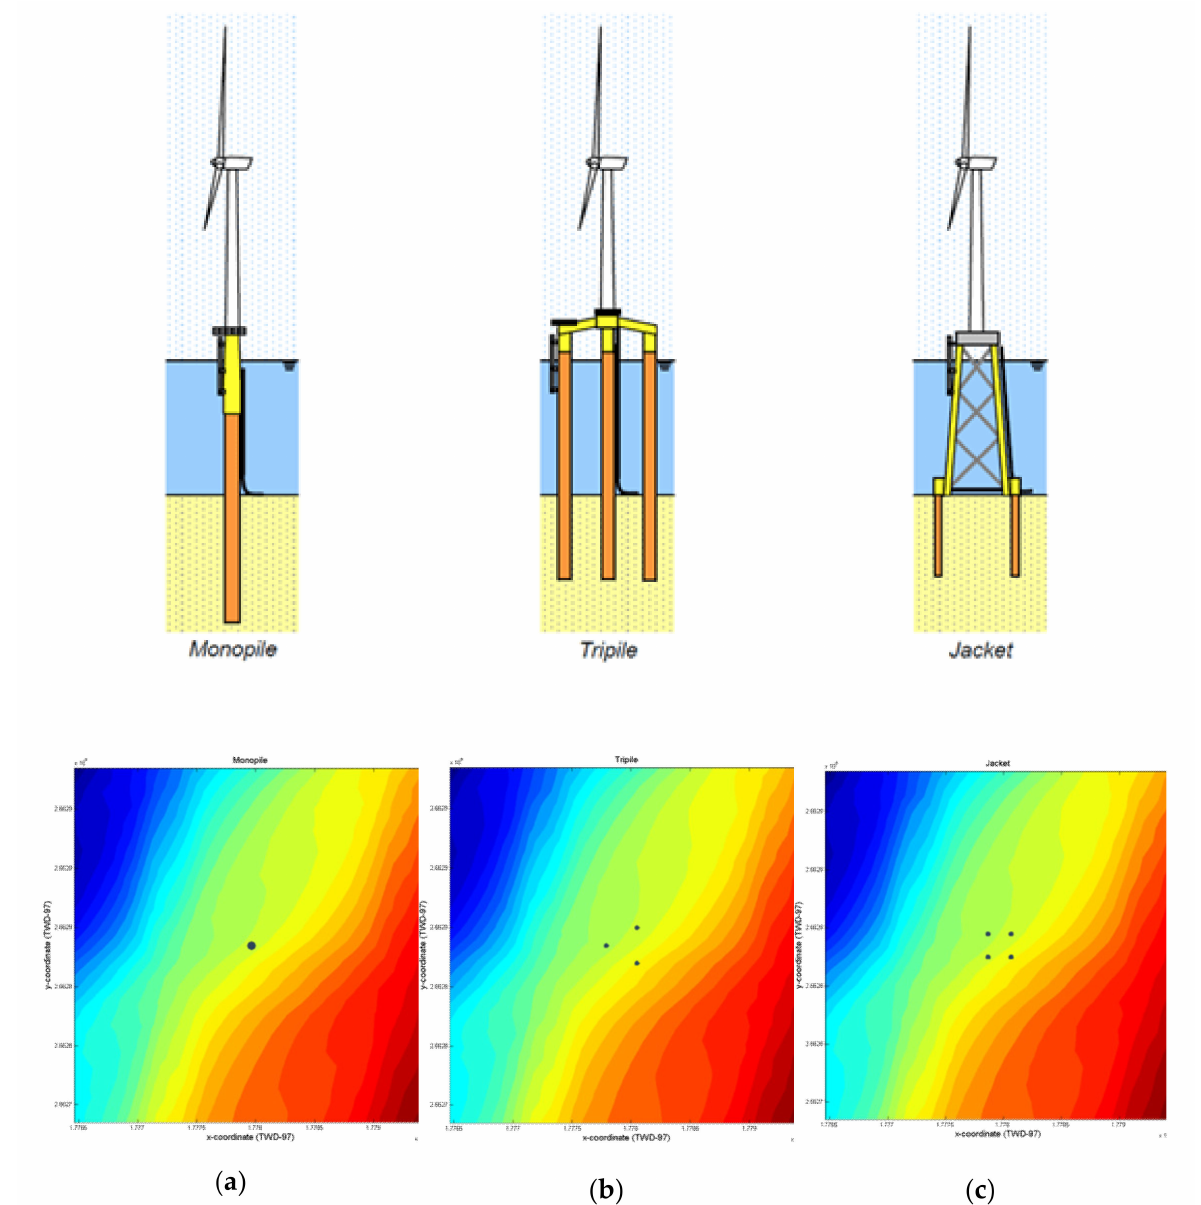
Figure 7. Different foundation types: ( a ) monopile; ( b ) tripile; ( c ) jacket. The offshore wind foundation type images are from [23].